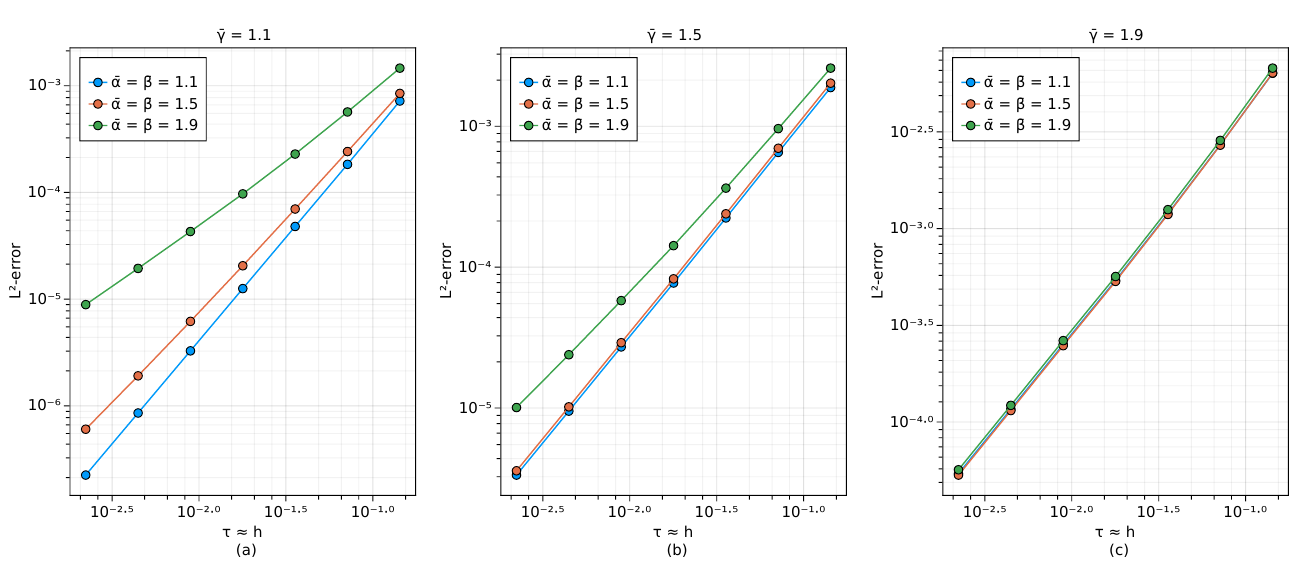
Figure 1. Error plots for E 1 calculated by (54) with respect to τ ≈ h obtained for different orders of N fractional derivatives: α ∈ { 1.1,1.5,1.9 } ; β = α ; ( a ) γ = 1.1. ( b ) γ = 1.5. ( c ) γ =